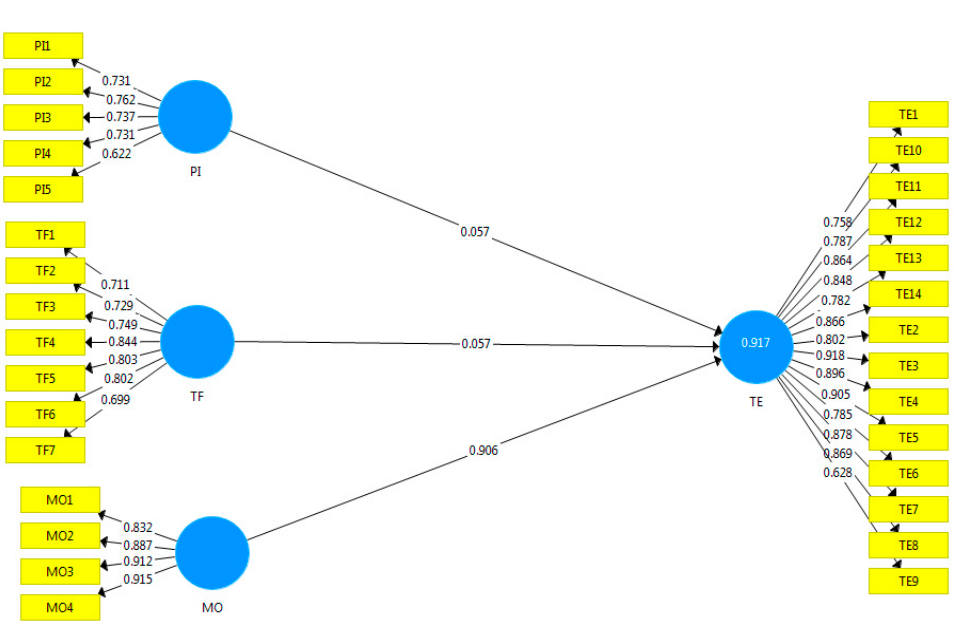
Figure 2. The measurement model.